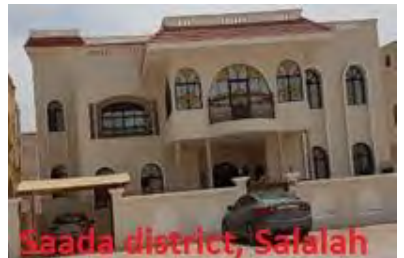
Figure 21. Fac¸ade’s photograph building location